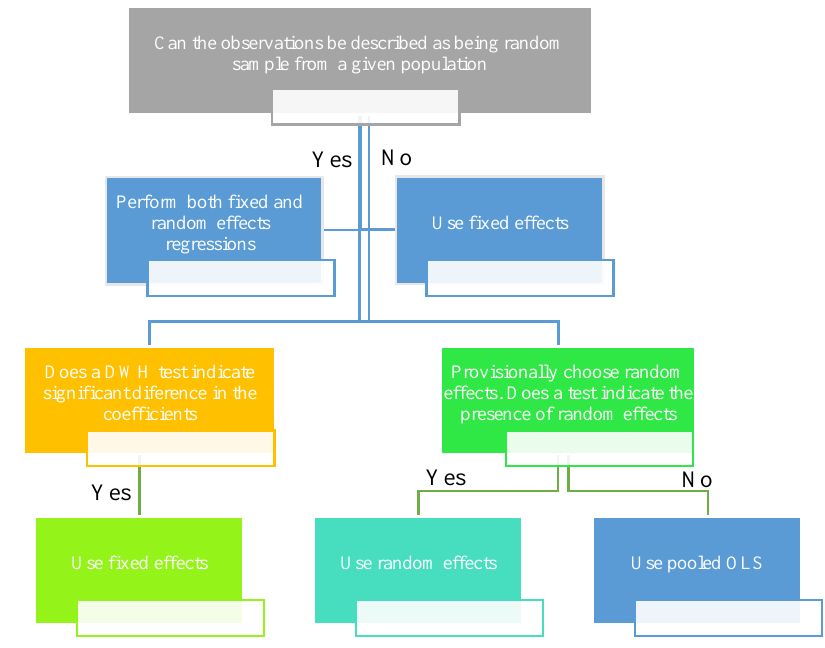
Figure 4. Flow chart for choosing the appropriate